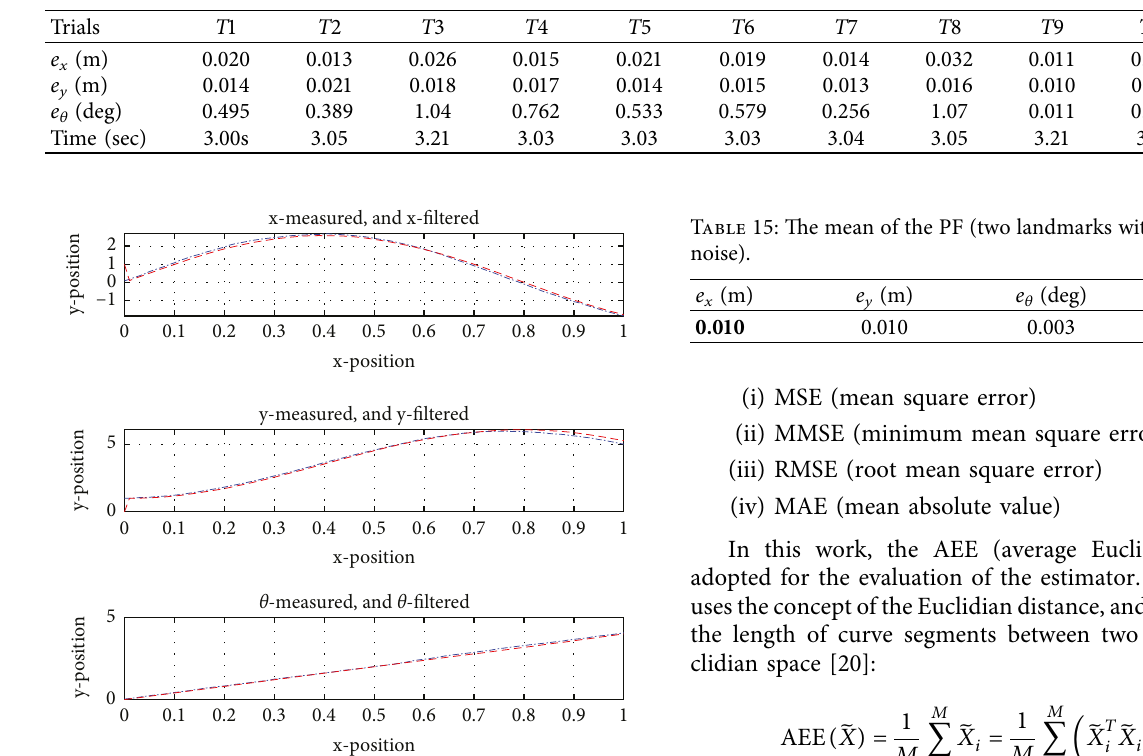
Table 14: The mean of different trials with the PF (two landmarks and Gaussian noise).